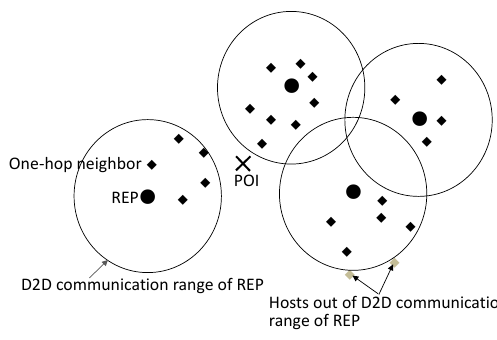
G i (cid:54) = S T ≠ 𝑆 𝑇 . Figure 8. Example of case where ∪ i ∈ S R 𝑅